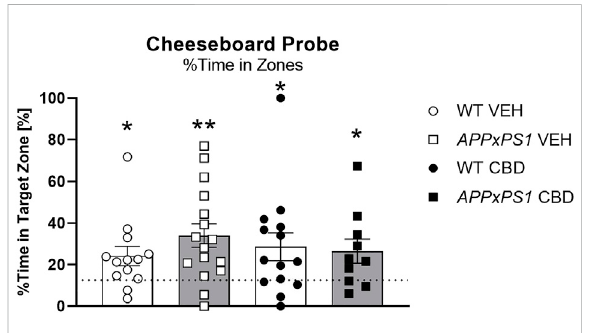
FIGURE 3 No effect of long-term CBD on recall of spatial memory. Percentage [%] of time spent in the target zone at A probe test in APPxPS1 and WT mice treated daily with 20 mg/kg CBD for 8 months. Data were analysed using a single sample t-test against chance levels, i.e., 12.5%,corresponding to 1/8zones. Data presented as mean ± SEM. Signi fi cant t-tests against chance are indicated by asterisks (* p < 0.05; ** p < 0.01). N = 13 WT VEH,